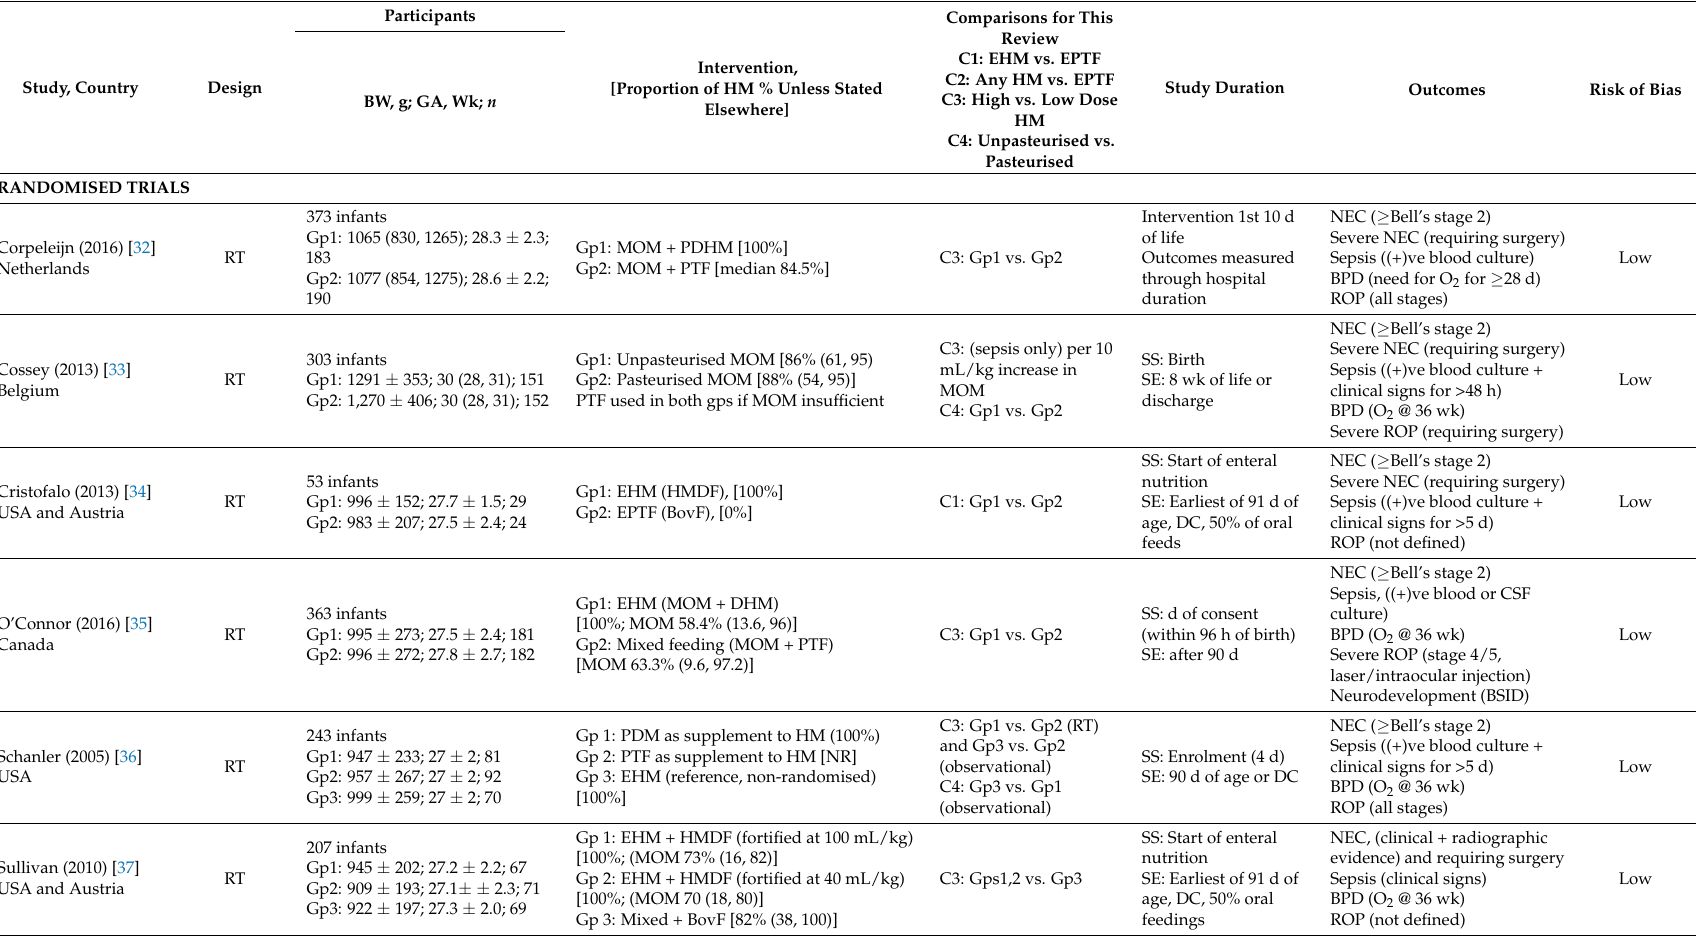
Table 1. Characteristics of included